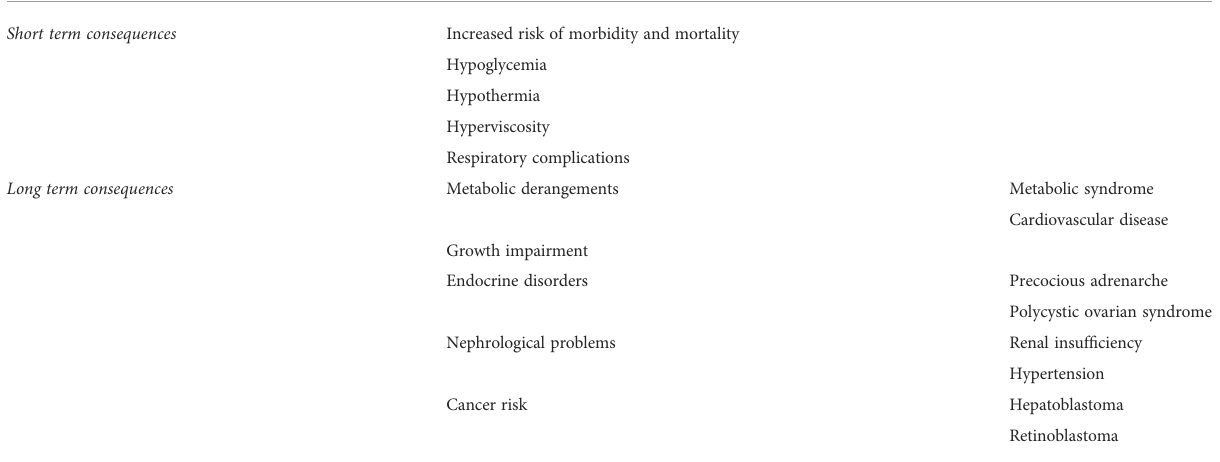
TABLE 2 Consequences of intrauterine growth